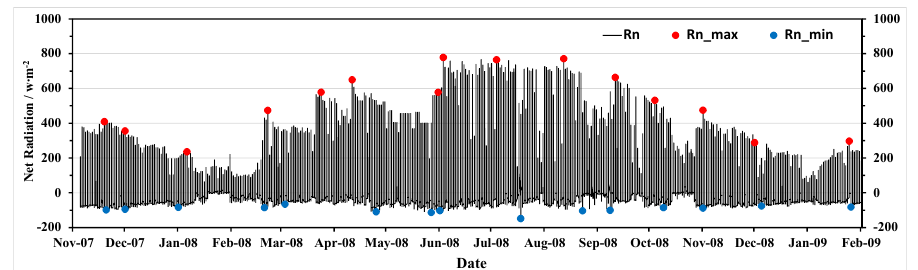
Figure 3. Hourly net radiation ( R n ), monthly maximum ( R n_max ), and monthly minimum ( R n_min ) values of net radiation at the Yingke site from November 2007 to January 2009. Table 2 Monthly total of the meteorological elements observed at the Yingke site from November 2007 to January 2009.